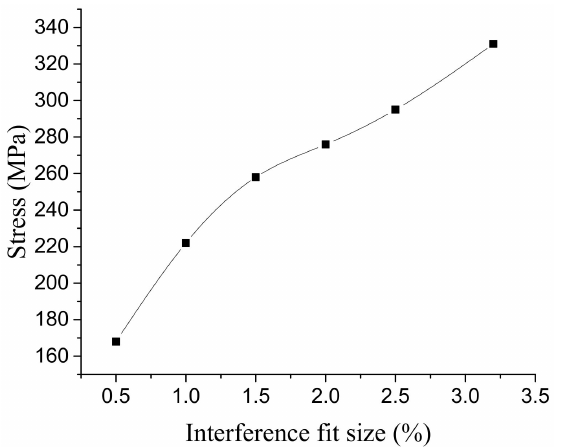
Figure 13. Variation of connecting plate’s maximum stress with interference fit size.